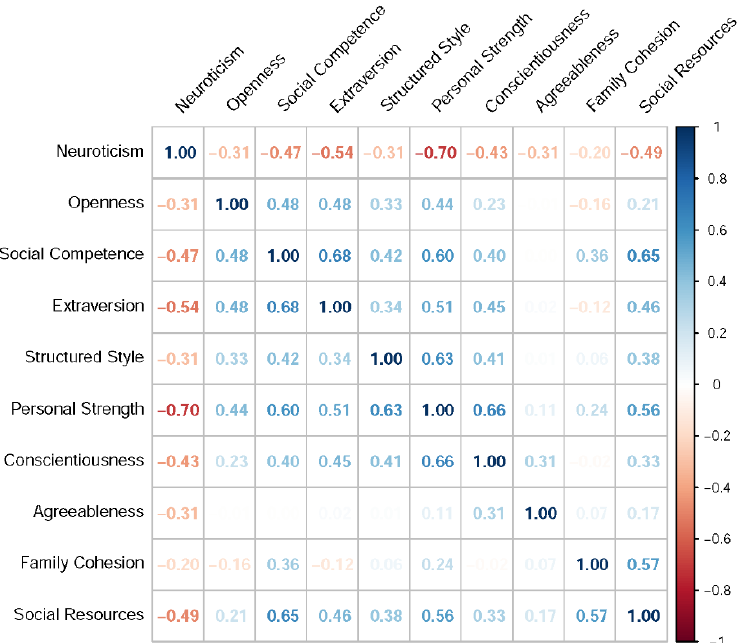
Figure 3. The correlations between each RSA score and each personality dimension.